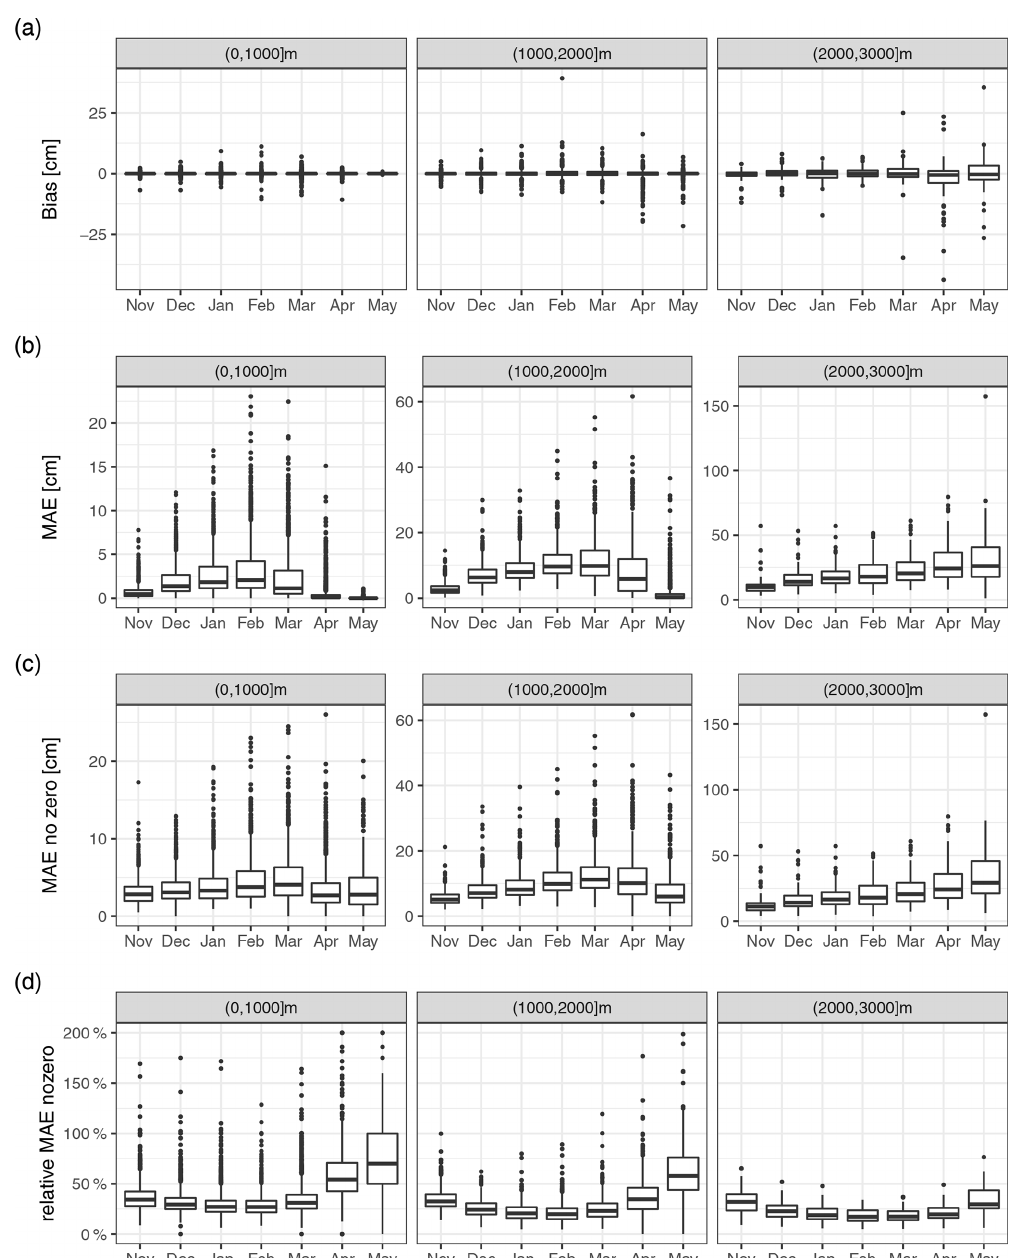
Figure A3. Cross-validation metrics for the gap-filling approach: (a) bias, (b) mean absolute error (MAE), (c) mean absolute error for non- zero values (MAE no zero), and (d) non-zero MAE divided by the true non-zero mean (relative MAE no zero). Panels show the 1000m elevation bands indicated in the title. The boxplots represent statistical quantities. The box indicates the first and third quartile, the bold line inside the box is the median, the vertical lines outside the box extend up to the most extreme point but at most 1.5 times the interquartile range (IQR; height of the box), and, finally, points below and above 1.5 · IQR of the first and third quartile are shown as separate